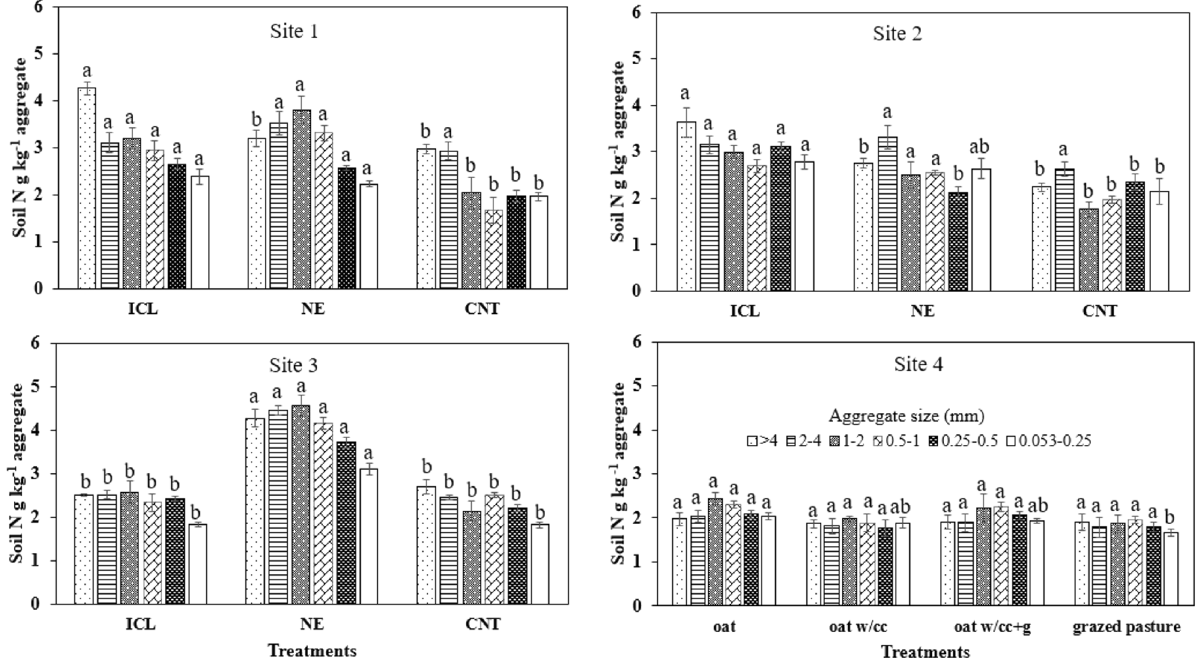
Figure 2. Soil aggregate-associated nitrogen concentration at 0–5 cm depth as influenced by different production systems at sites 1, 2, 3, and 4. Under each site, bars followed by different letters within an aggregate size at different treatments are significantly different at P ≤ 0.05 according to Fisher’s LSD. ICL integrated crop– livestock, NE natural ecosystem, CNT control, CC cover crop, g grazing.